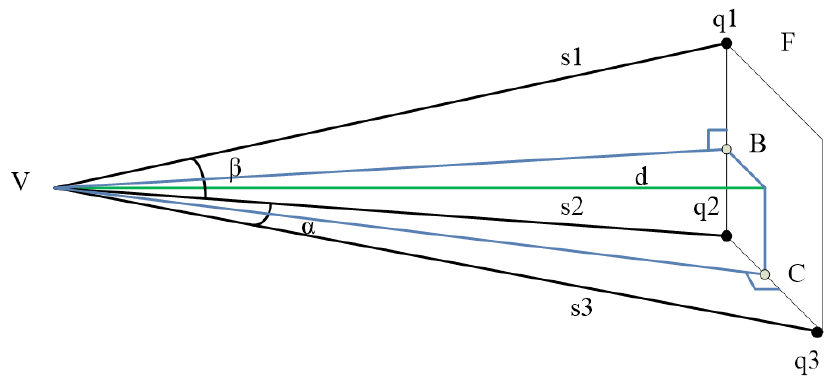
Figure 7. Set the adaptive distance